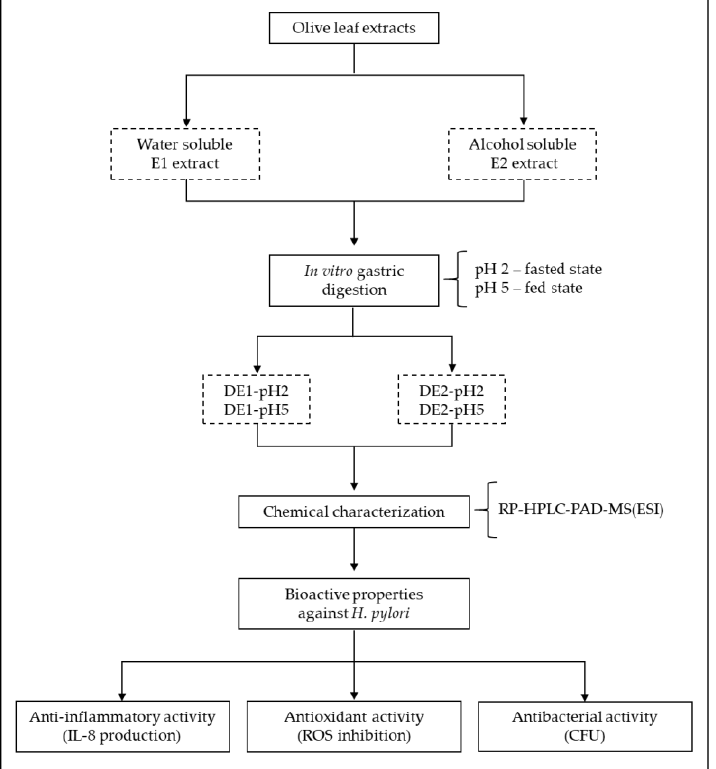
Figure 1. Flowchart summarizing the main experimental procedures for evaluation of the bioactive properties of olive leaf extracts and their gastric digests. properties of olive leaf extracts and their gastric